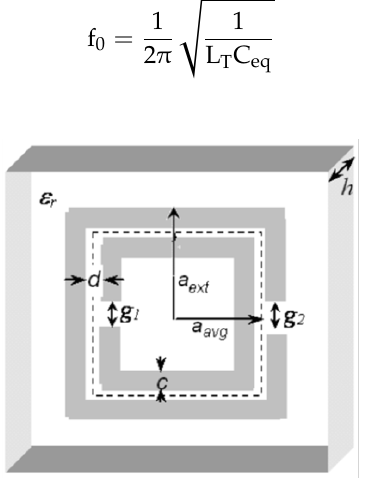
Figure 10. Schematic view of a circular split-ring resonator.